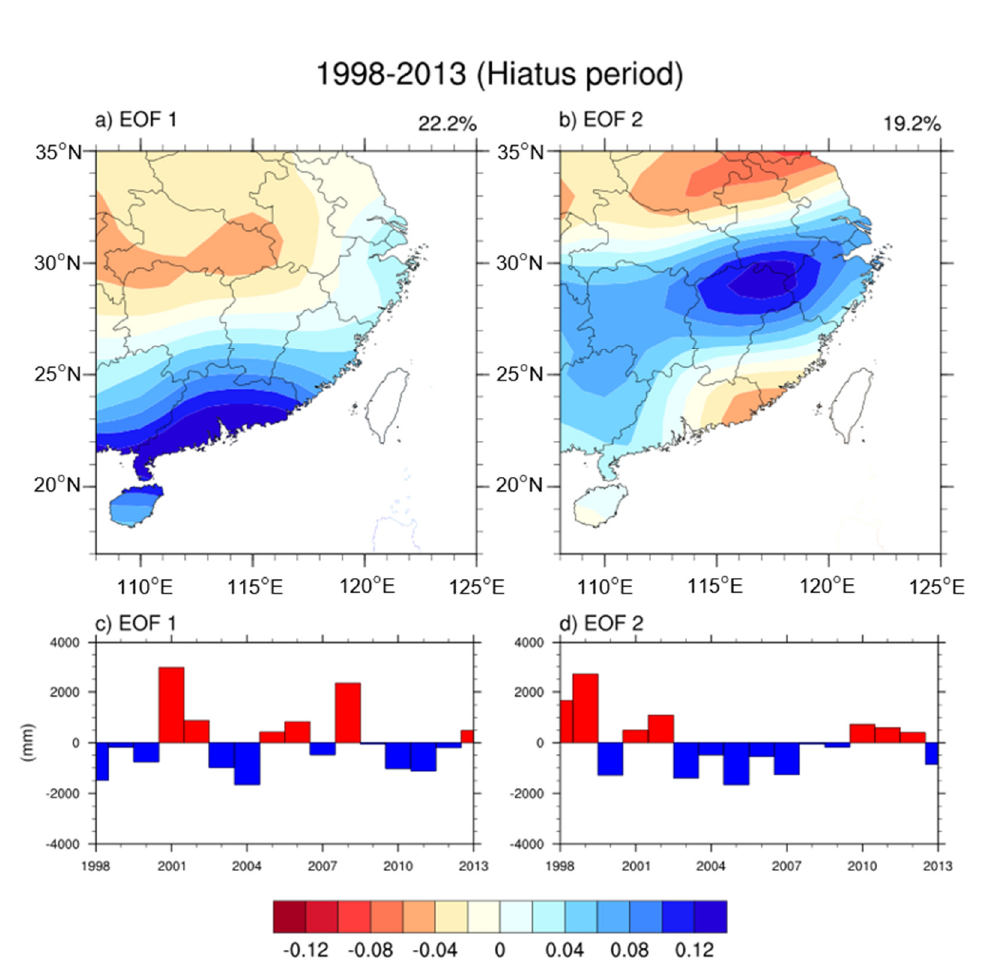
Figure 11. Same as Figure 7, but for the hiatus period (1998–2013).